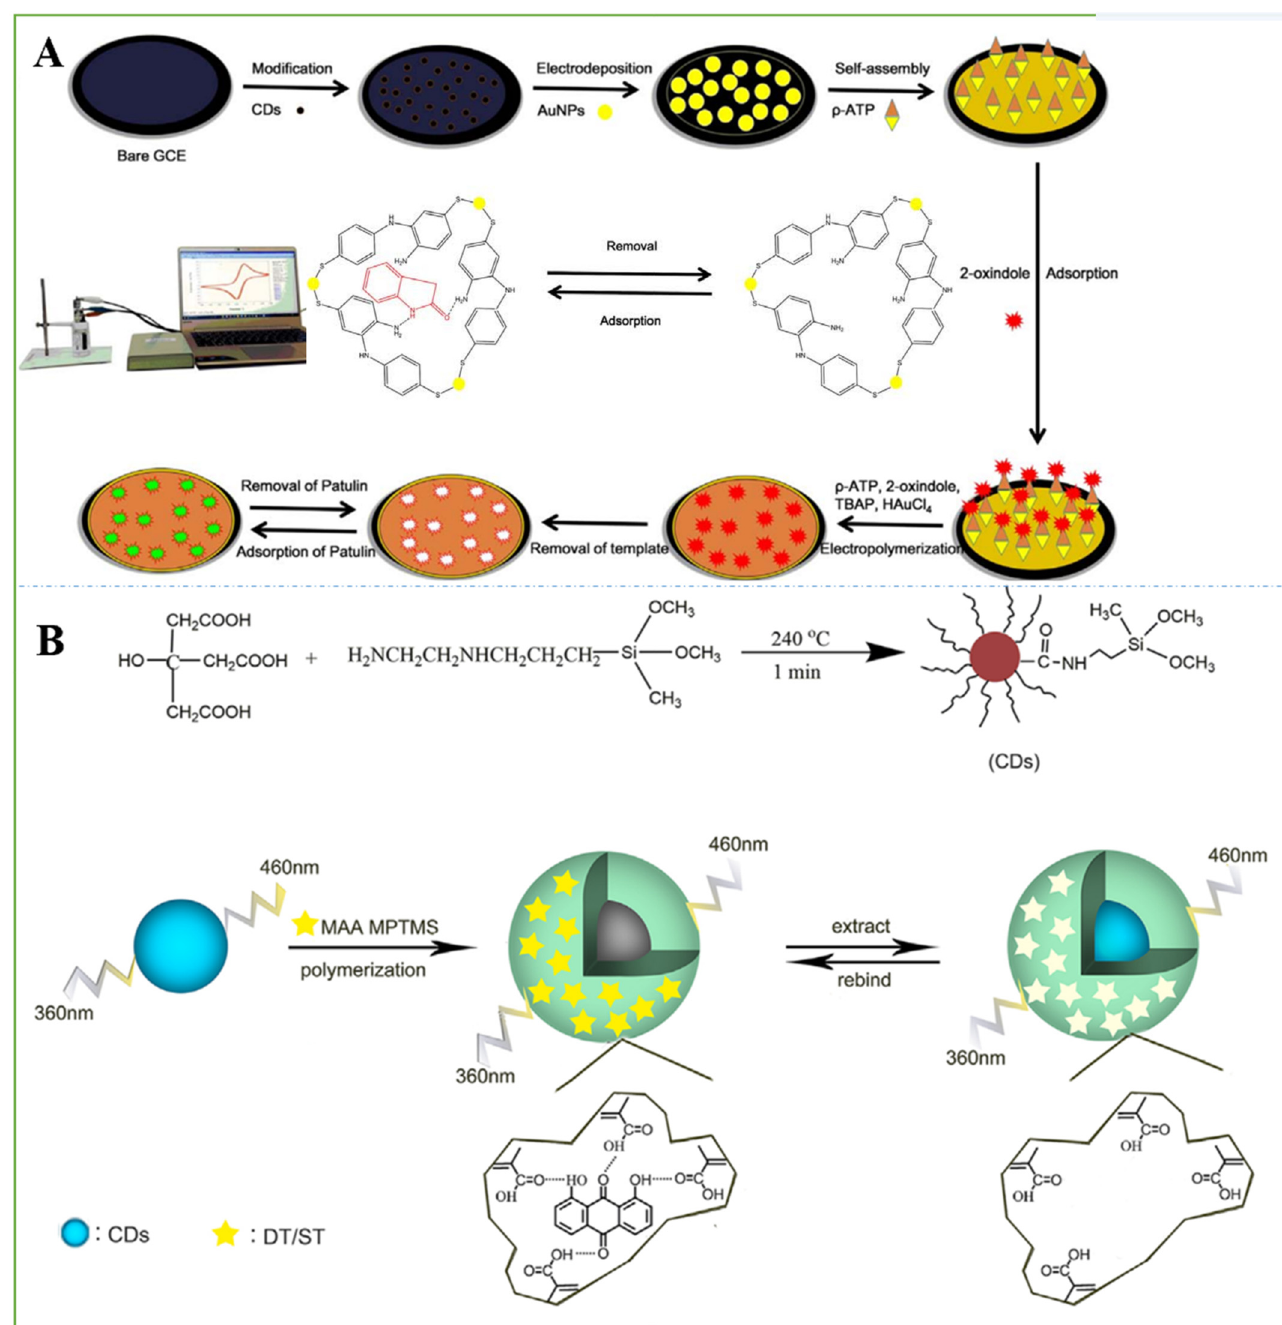
Figure 8. ( A ) Preparation procedure of the MIP-Au/CS-CDS/GCE. Reprinted with permission from [127]. Copyright 2017 Elsevier. ( B ) Preparation of CDs@MIP. Reprinted with permission from [42]. Copyright 2016 Elsevier.